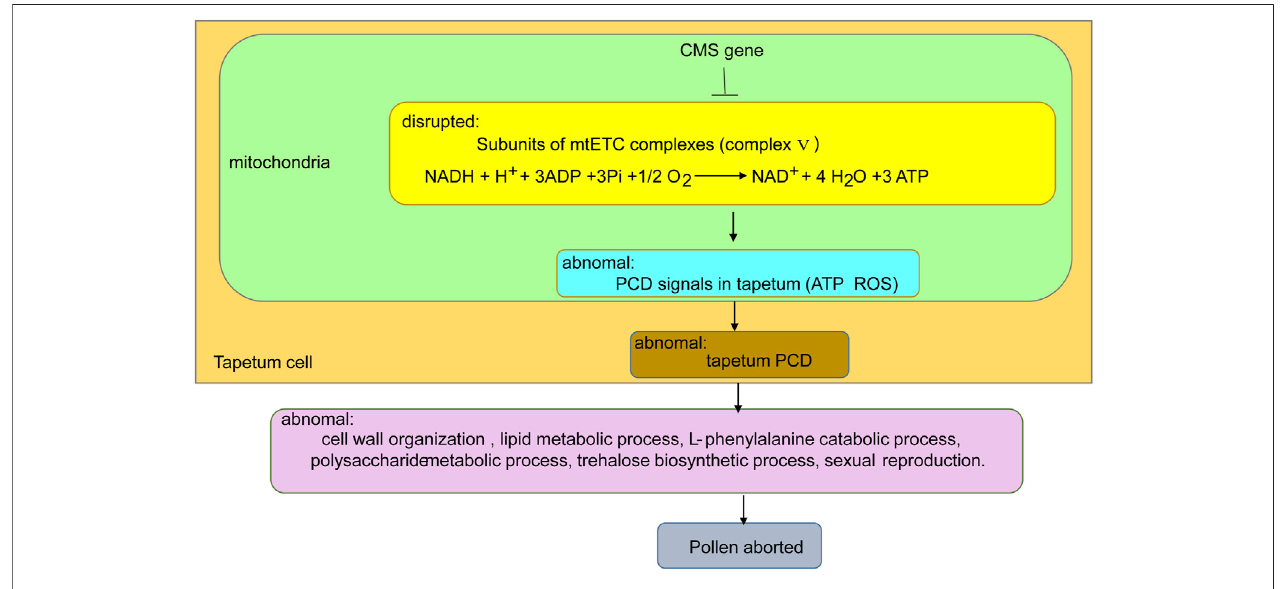
FIGURE 8 | A proposed working model of pollen abortion in